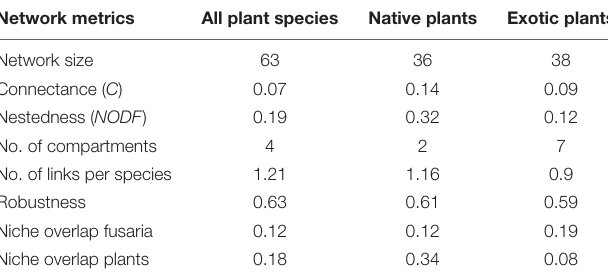
TABLE 2 | Attributes of plant- Fusarium ecological networks in Mexico, including the following: all plant species, native plant species only and introduces plant species